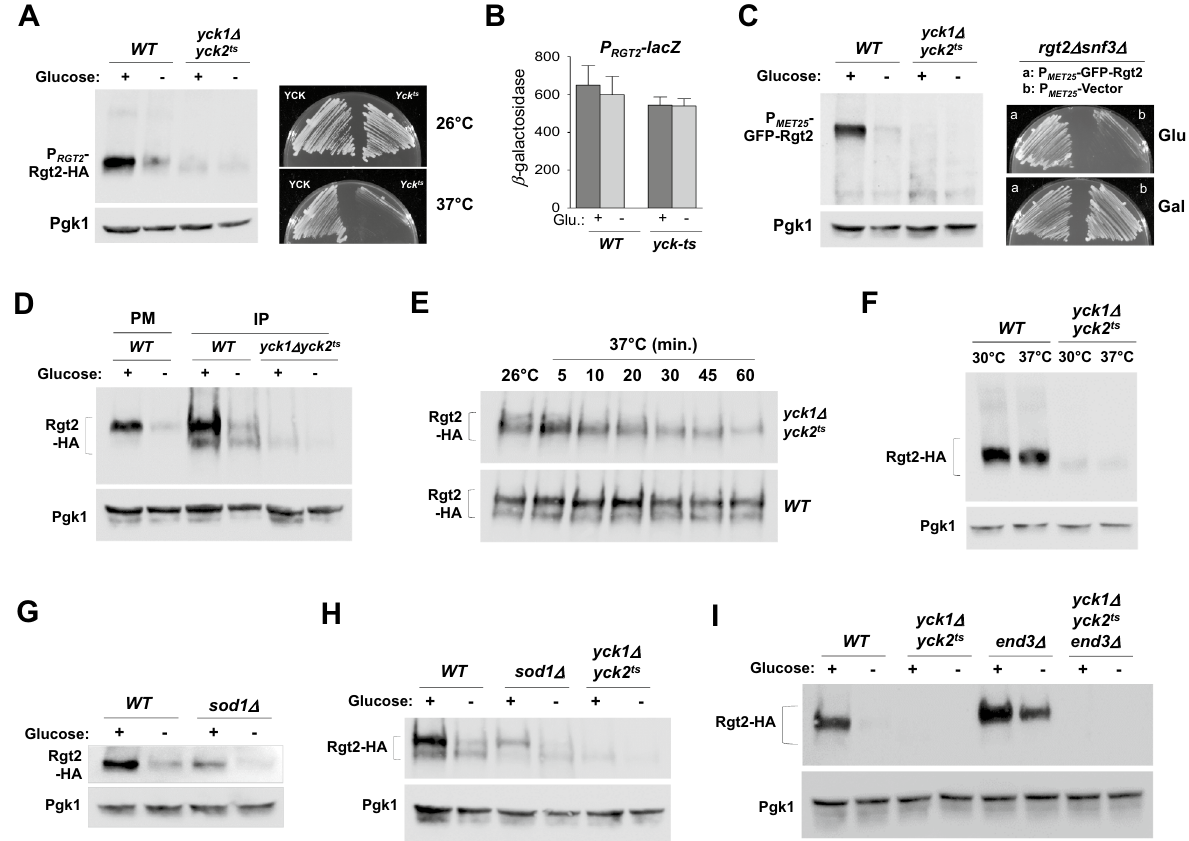
Figure 1. The Ycks are required for the stability of Rgt2 at the cell surface. ( A ) Western blot analysis of Rgt2-HA protein levels in WT (LRB939) and yck1Δyck2 ts (LRB1613) cells. C-terminally HA-tagged Rgt2-HA was expressed from the RGT2 promoter (P RGT2 ). Cells were grown in selective SC medium with 2% glucose to mid- log phase (O.D 600nm = 1.2–1.5) and equal amounts of cells were shifted to SC medium containing glucose (2%) or galactose (2%) for 1 h. The yck1Δyck2 ts cells were incubated at 37 °C for 30 min before the precultures were shifted to fresh glucose medium or galactose medium. Membrane fractions were immunoblotted with anti-HA antibody. Pgk1 was used as loading control (left). WT and yck1Δyck2 ts cells were incubated at the permissive temperature 26 °C or the restrictive temperature 37 °C for 2 days (right). ( B ) RGT2-lacZ expression in WT and yck1Δyck2 ts cells. β-Galactosidase activity was assayed in permeabilized cells and expressed in Miller Units. Values are means for at least three independent experiments. ( C ) Western blot analysis of GFP-Rgt2 protein levels in WT and yck1Δyck2 ts cells. GFP-Rgt2 was expressed from the MET25 promoter (P MET25 ), which is not regulated by glucose 15 (left). The growth defect of the rgt2 snf3 double mutant is complemented by expression of GFP-Rgt2 (right). The rgt2Δsnf3Δ mutant (MSY441) transformed with GFP-Rgt2 (a) and an empty vector (b) was scored for growth on SC- medium containing glucose (2%) or galactose (2%). ( D ) WT and yck1Δyck2 ts cells expressing Rgt2-HA were grown as described in ( A ). Whole cell lysates were immunoprecipitated (IP) with agarose-conjugated anti-HA antibody, and the precipitates were analyzed by Western blotting with anti-HA antibody. PM, membrane fractions. ( E ) WT and yck1Δyck2 ts cells expressing Rgt2-HA were grown in galactose (2%) to mid-log phase (O.D 600nm = 1.2–1.5) at 26 °C, and the preculture was shifted to 37 °C for various periods of time as indicated before adding glucose (2%). Then, the cells were grown for 1 h, and Rgt2-HA levels were determined by immunoprecipitation and Western blotting. ( F ) The cells were grown as described above ( E ), but the preculture was shifted to 30 °C and 37 °C before adding glucose (2%). Membrane fractions were immunoblotted with anti-HA antibody. ( G , H ) Western blot analysis of Rgt2-HA protein levels in WT (BY4742) and sod1Δ (KLS62) cells. Membrane fractions were immunoblotted with anti-HA ( G ). Whole lysates of WT , yck1Δyck2 ts , and sod1Δ cells were immunoprecipitated (IP) with agarose-conjugated anti-HA antibody, and the precipitates were analyzed by Western blotting with anti-HA antibody ( H ). ( I ) The Ycks are not involved in glucose starvation-induced endocytosis and degradation of Rgt2. Western blot analysis of Rgt2-HA protein levels in WT (LRB939) and yck1Δyck2 ts (LRB1613), end3Δ (KFY127), and yck1Δyck2 ts end3Δ (KLS95) cells. Membrane fractions were immunoblotted with anti-HA. Pgk1 was used as loading